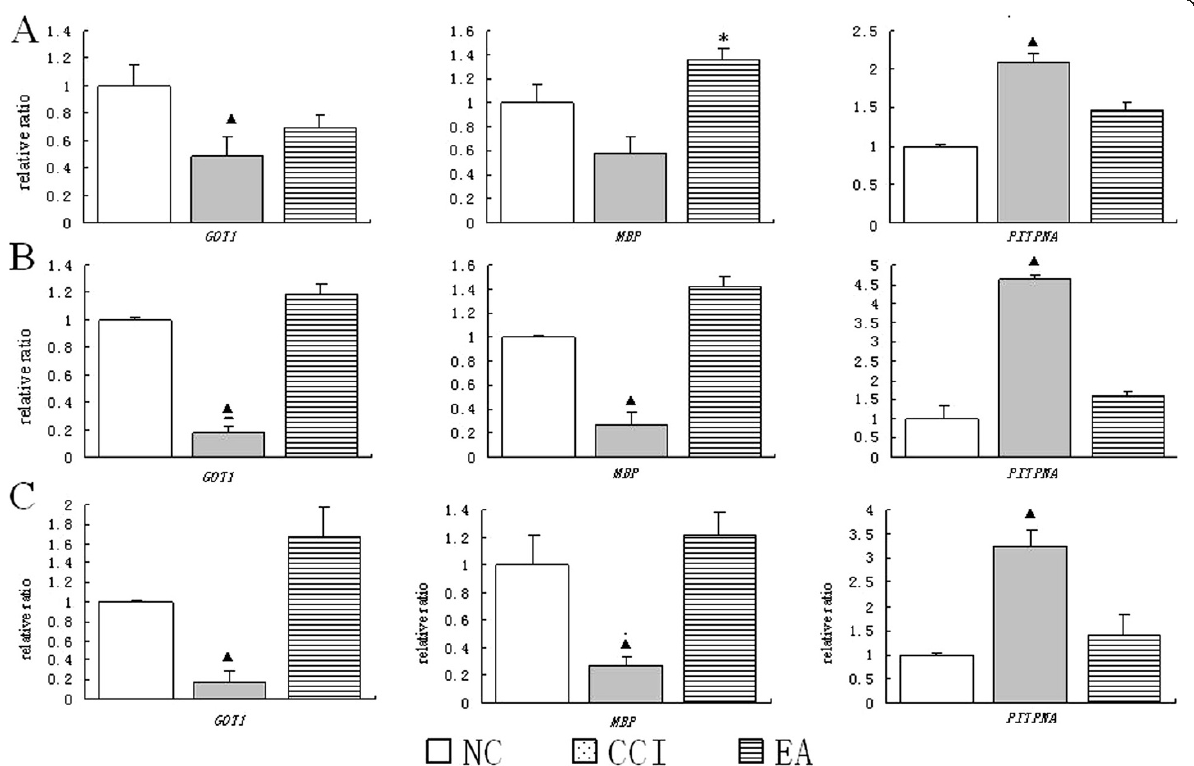
Figure 6 Expression changes of PITPNA , MBP , and GOT1 in the hippocampus in the NC, CCI, and EA groups were examined by different approaches. A: by quantitative real-time PCR; B: by Western blot; C: by 2-D. Data are presented as mean ± SD (n = 10 per group). ▲ P < 0.05, compared with the NC group; * P < 0.05, compared with the CCI